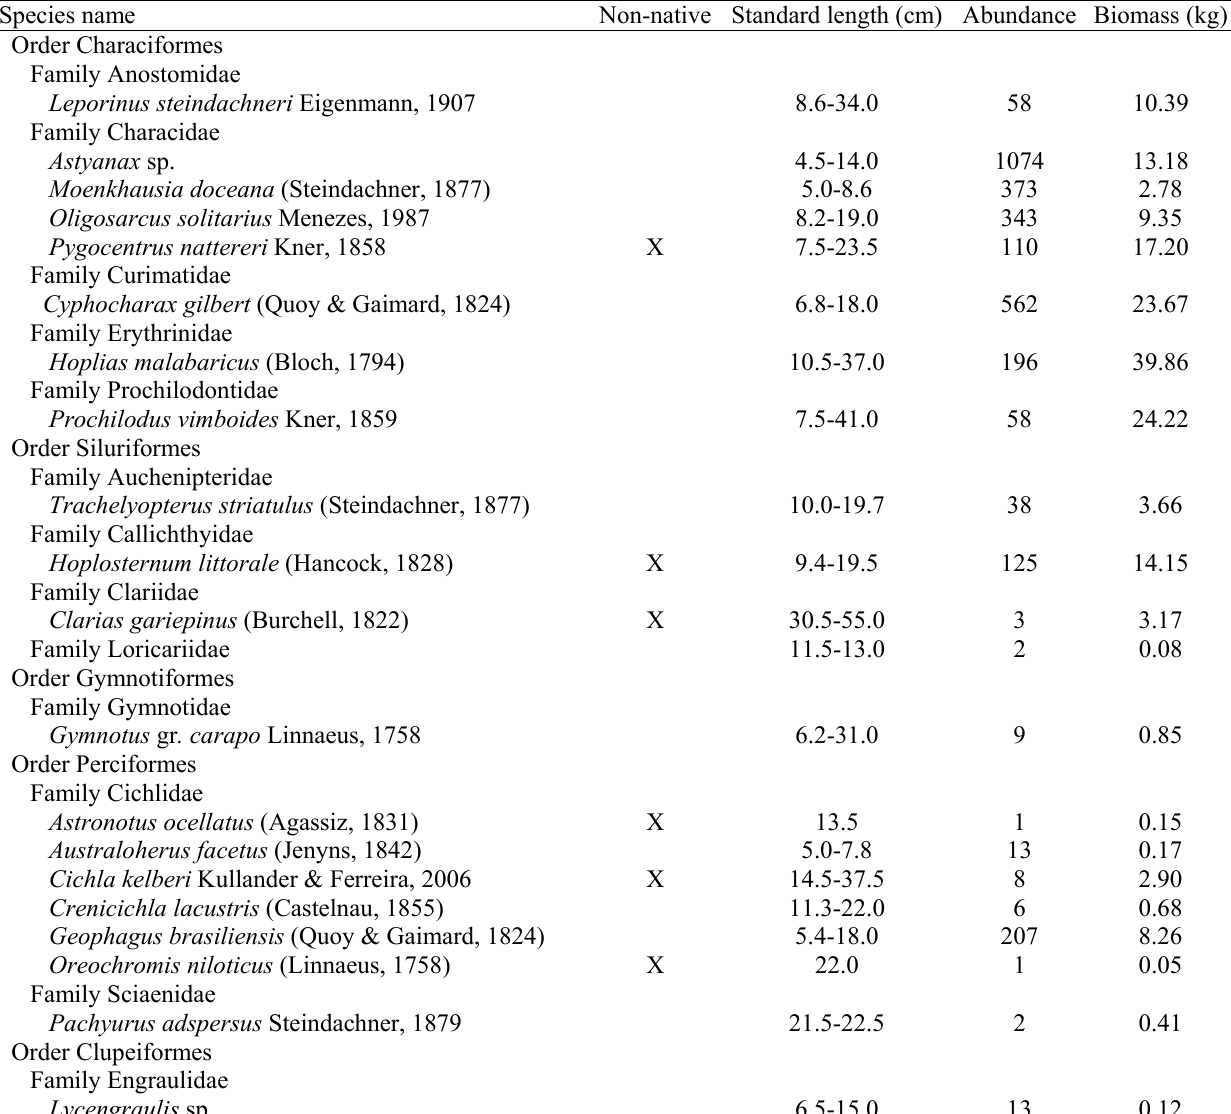
Table 1. List of collected species, presenting size ranges (standard lengths), total abundances and biomasses. Non-native species are also